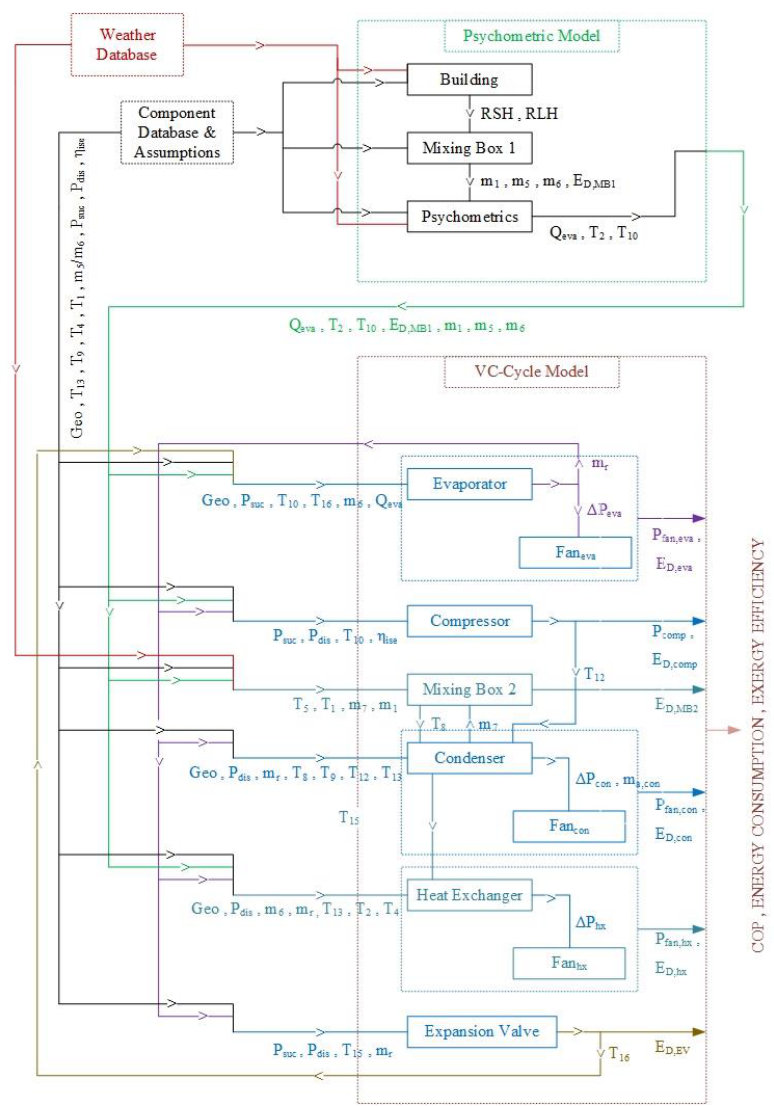
Figure 2. Data flowchart exploited in EES software to conduct energy and